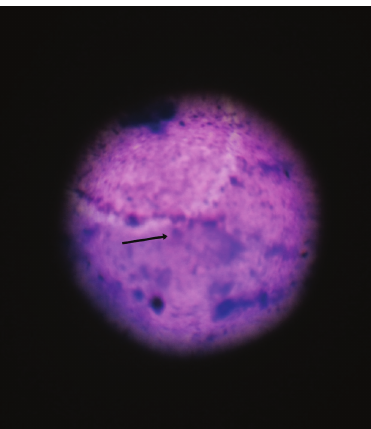
Figure 6: FNAC from breast lesion showing degenerated inflamma- tory cells in a necrotic background.